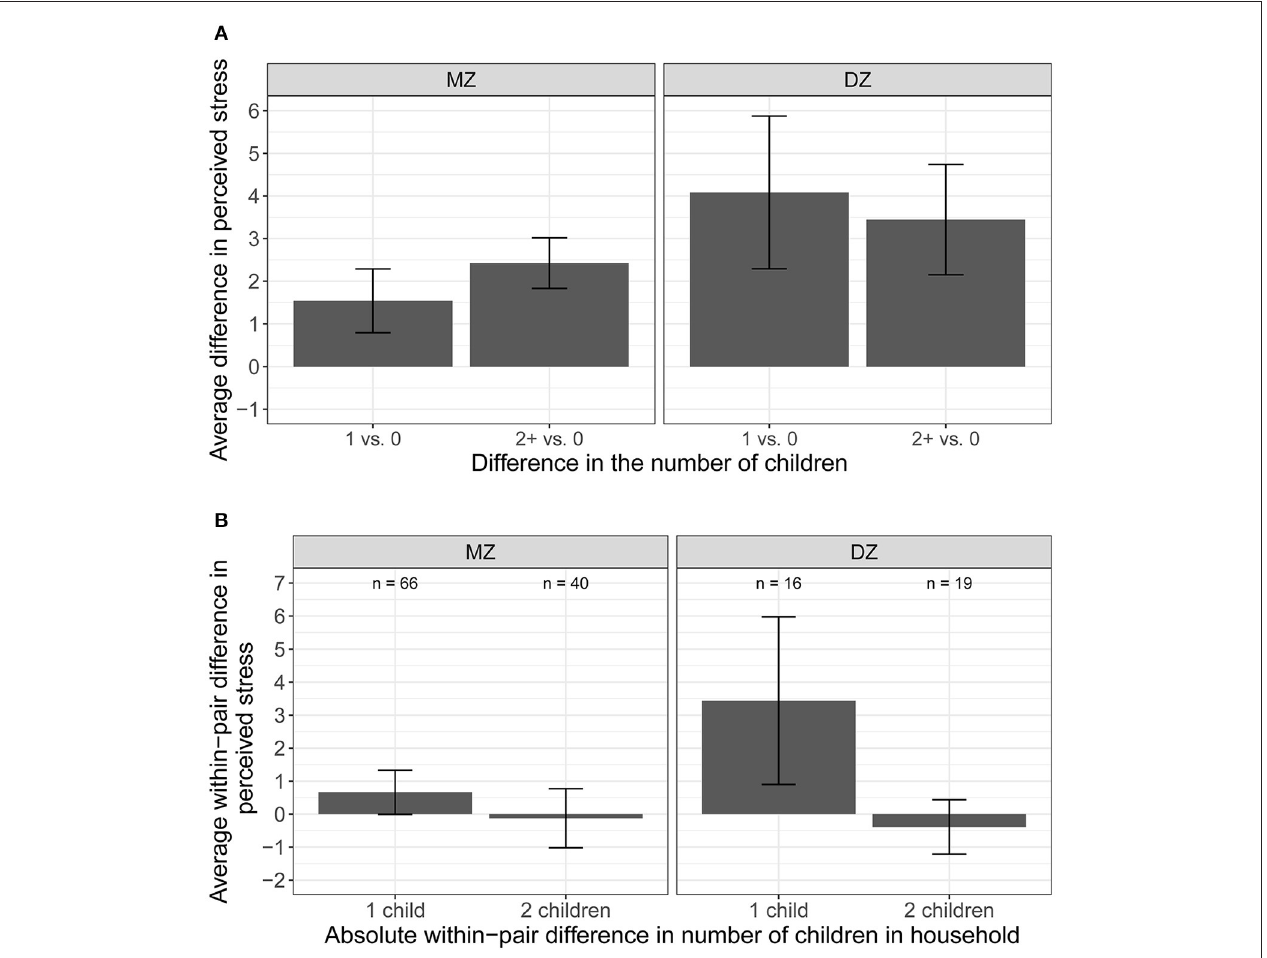
FIGURE 4 | Average difference and within-pair difference in perceived stress levels and children. (A) Average difference in perceived stress between participants with no children and one/two or more children in the household. (B) Average difference in perceived stress between member of the pair with children and the co-twin without children in the